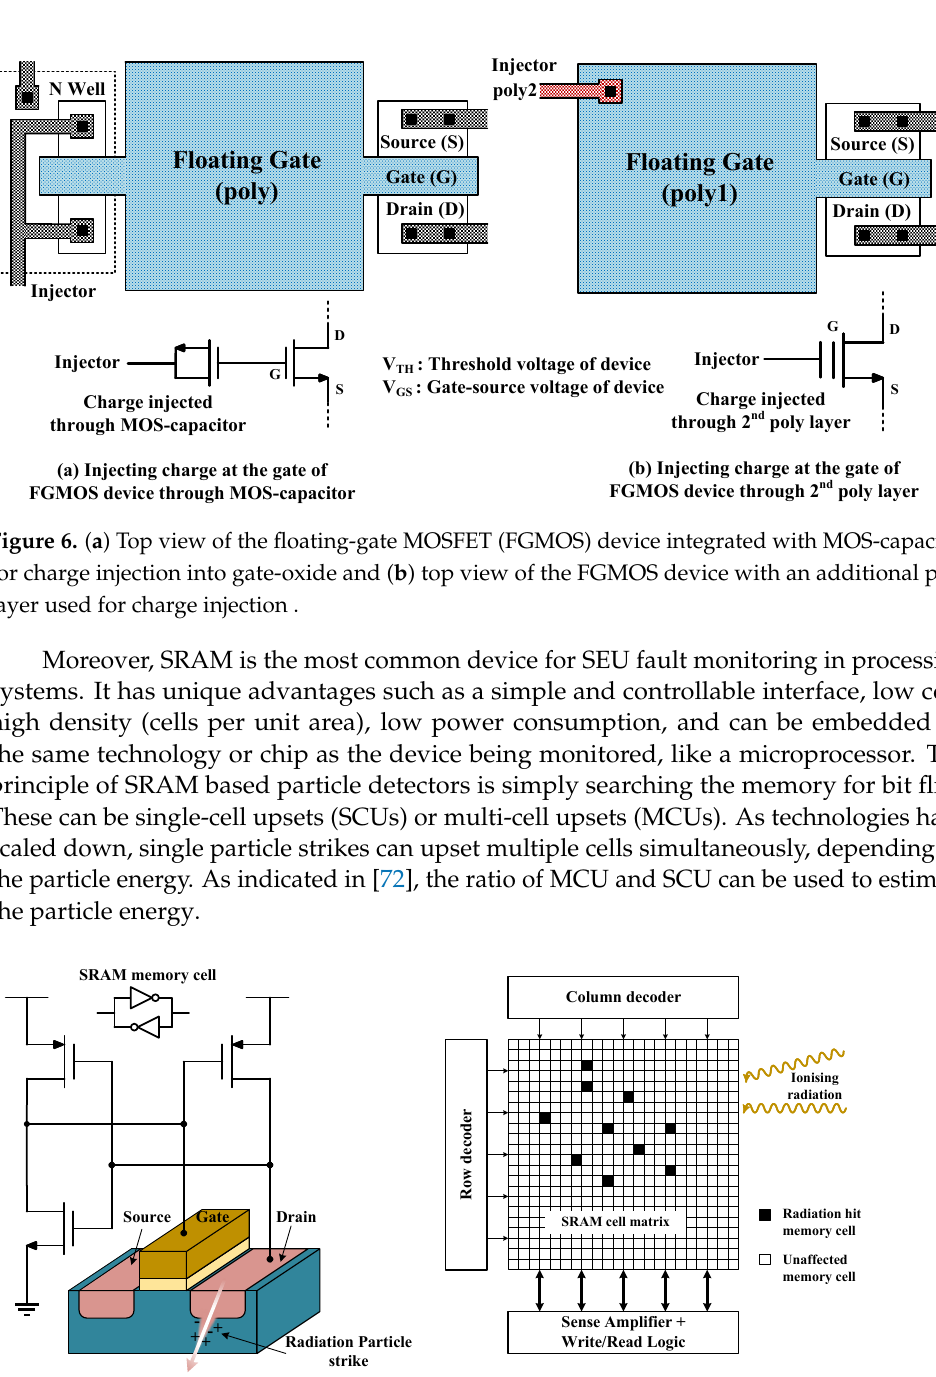
Figure 7. Mechanism of radiation strike and memory bit-flips on static random access memory (SRAM)